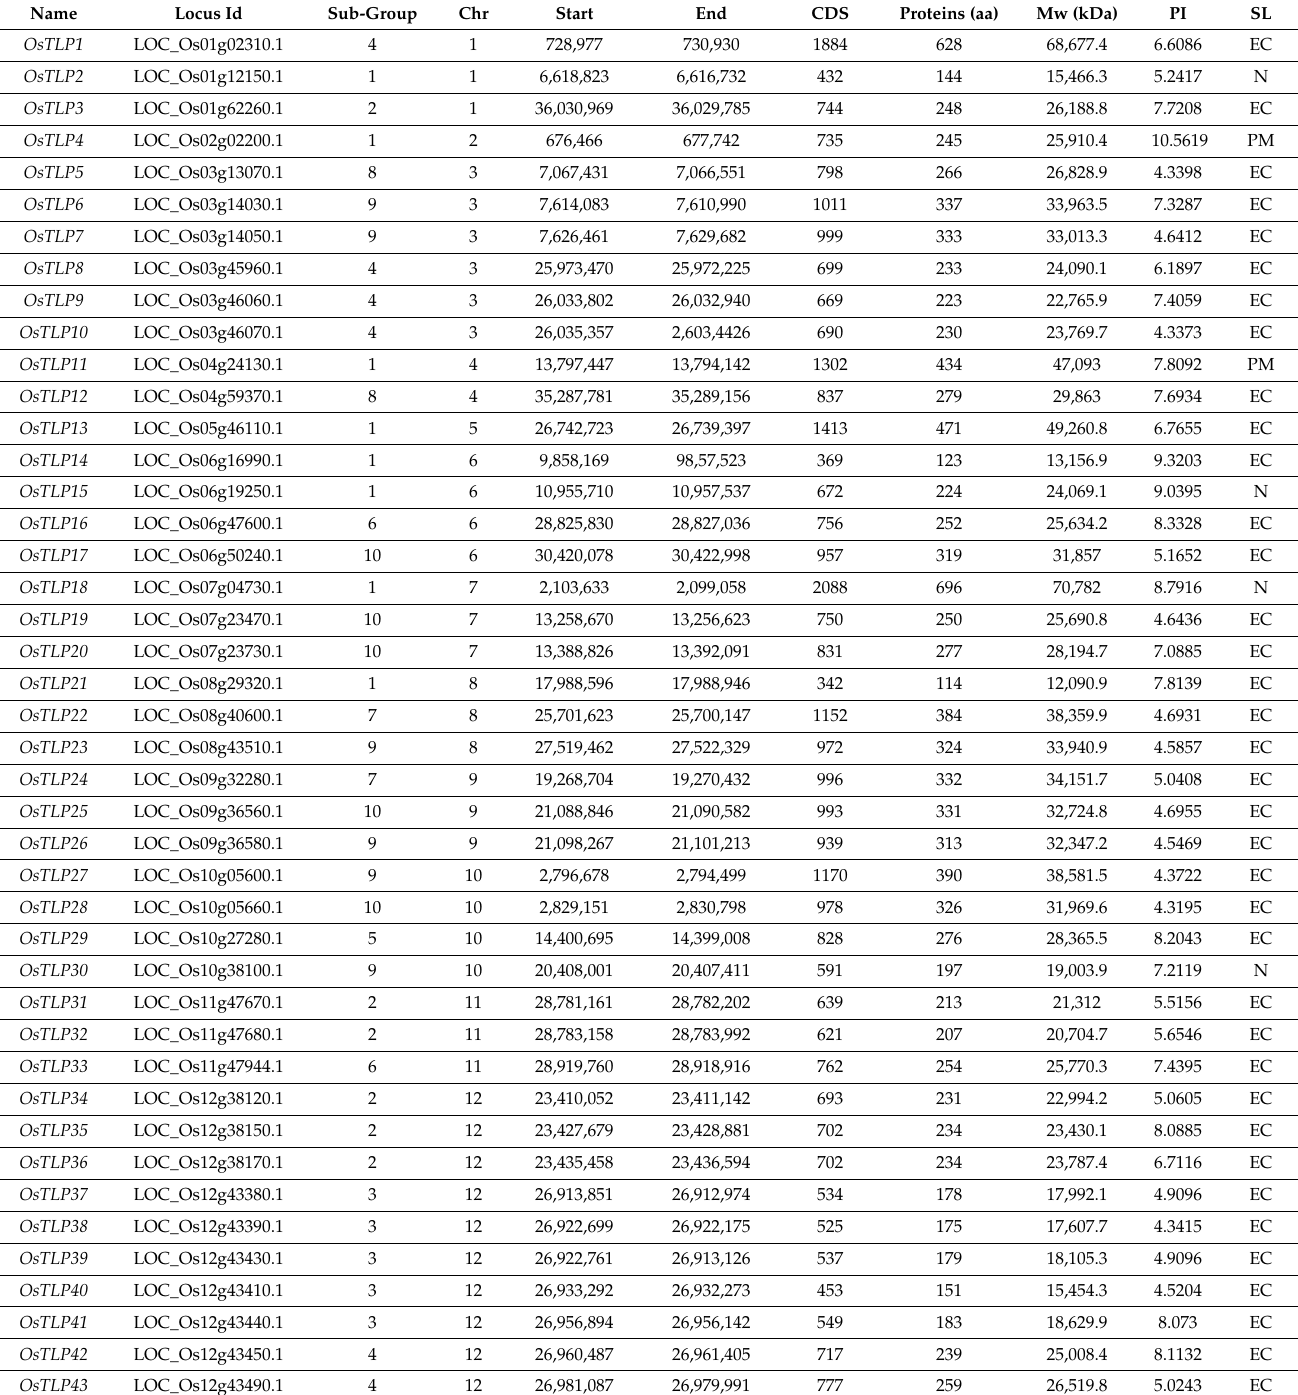
Table 1. The gene and protein features of TLP gene family members in Oryza sativa